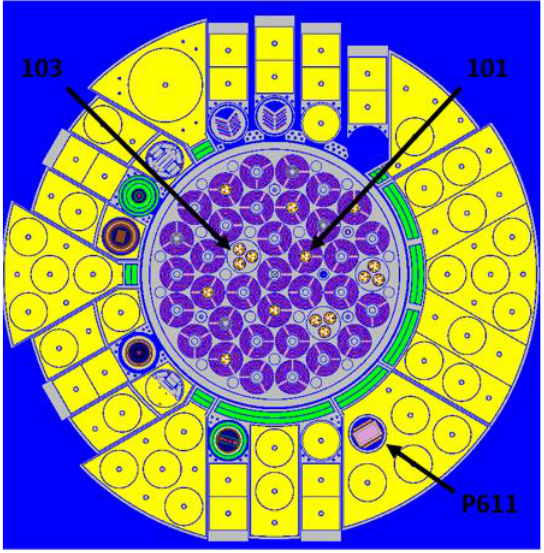
Fig. 1. Radial layout of the JHR reactor core model with TRIPOLI-4®.